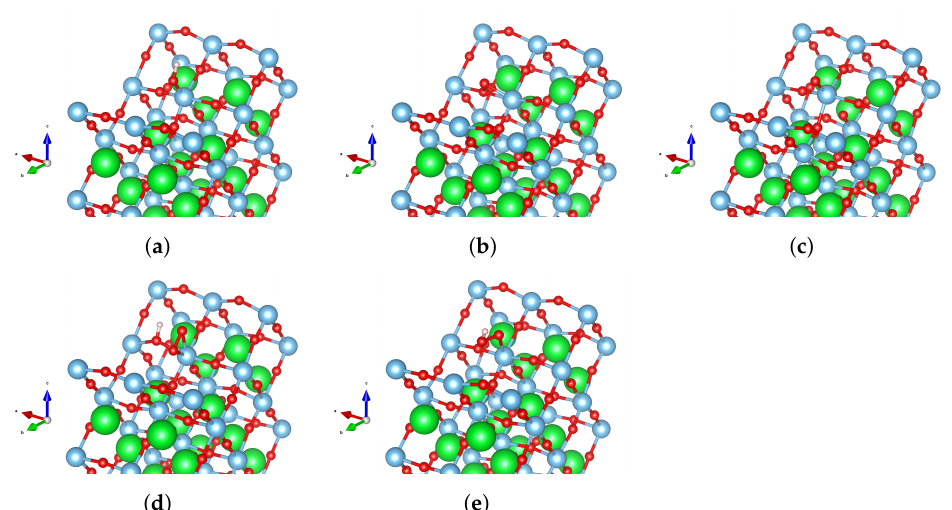
Figure 6. OER intermediates on the slope of the stepped surface. ( a ) HO * adsorbate on the slope region: E ads = 1.35 eV. ( b ) O * (O adsorbate on the slope region: E ads = 2.93 eV. ( c ) O * adsorbate surf ) on the slope region: E ads = 4.11 eV. ( d ) H (O OO * adsorbate on the slope region: E ads = 3.48 eV. surf ) ( e ) HOO * adsorbate on the slope region: E ads = 4.52 eV.